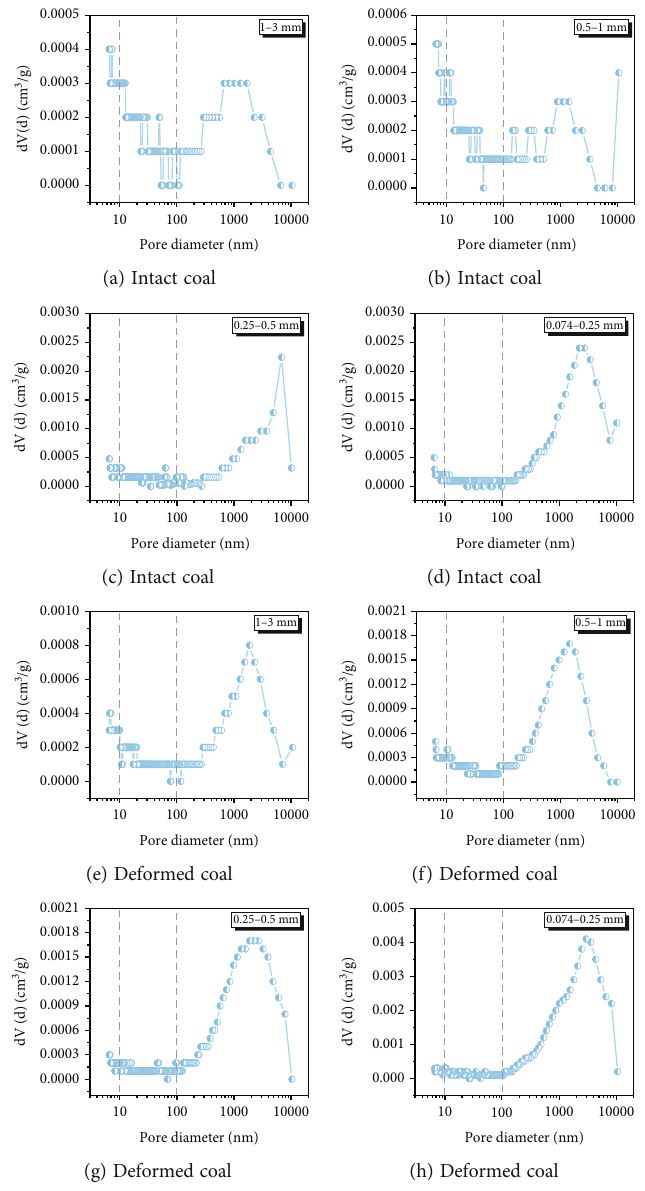
Figure 6: PSDs of macropores and